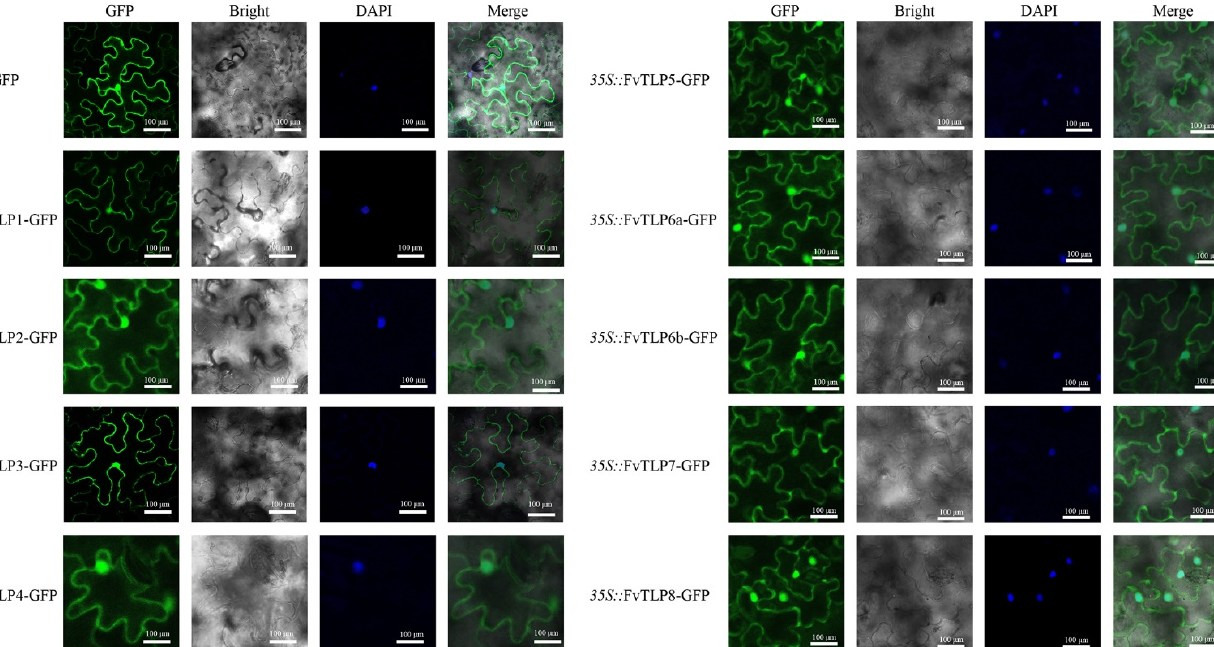
Figure 3. Cis -element analysis of FvTLP promoters. The distribution of cis -elements in the 2000-bp Figure 3. Cis ‐ element analysis of FvTLP promoters. The distribution of cis ‐ elements in the 2000 ‐ bp upstream promoter and the different types of cis ‐ elements are represented by different colors. upstream promoter and the different types of cis -elements are represented by different colors.